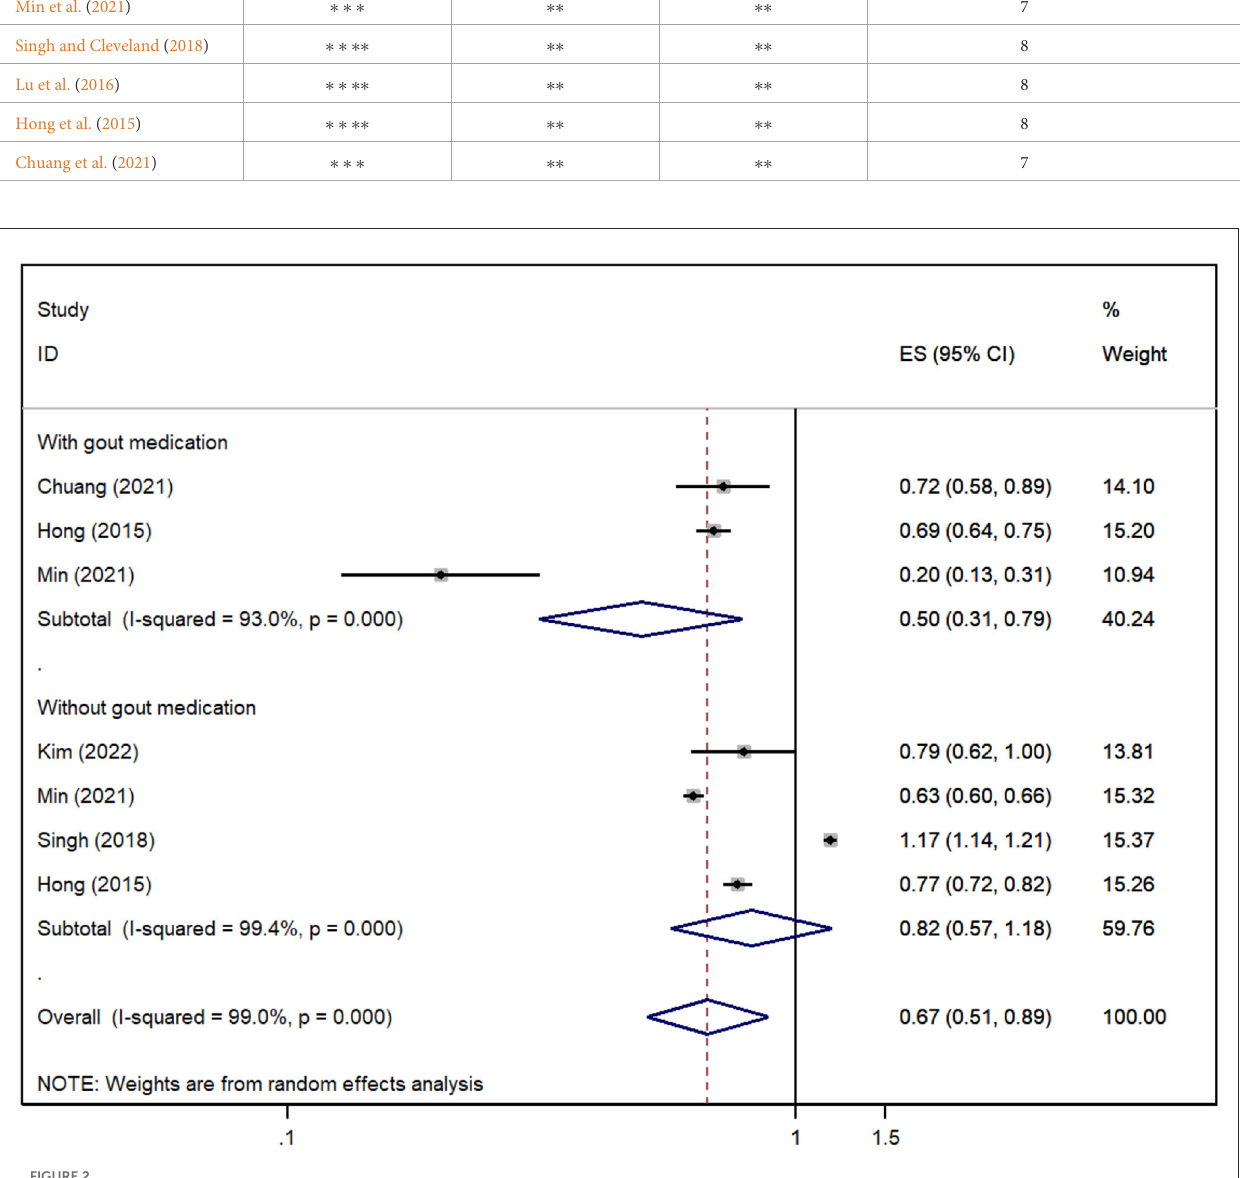
Meanwhile, gout seems to be a protective factor for AD and VD although the quality of evidence is low or very